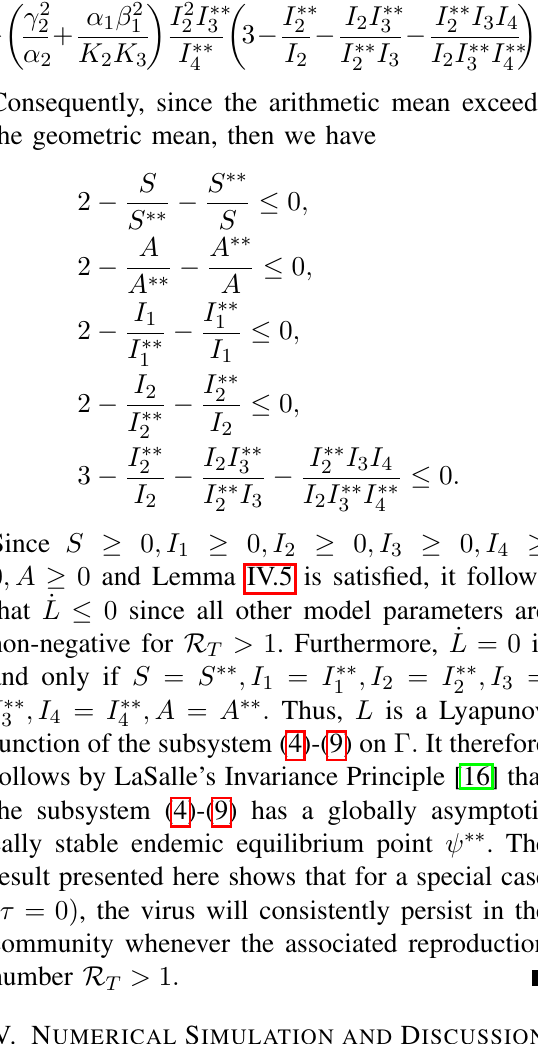
Table 1: Hypothetical Value of Parameters